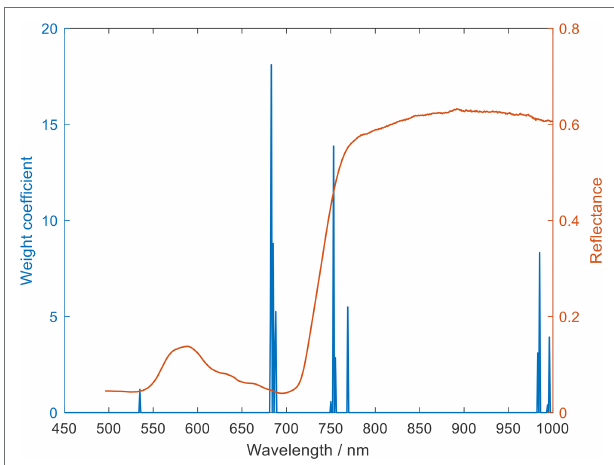
FIGURE 7 | Selected o spectral characteristics wavelength using ElasticNet.